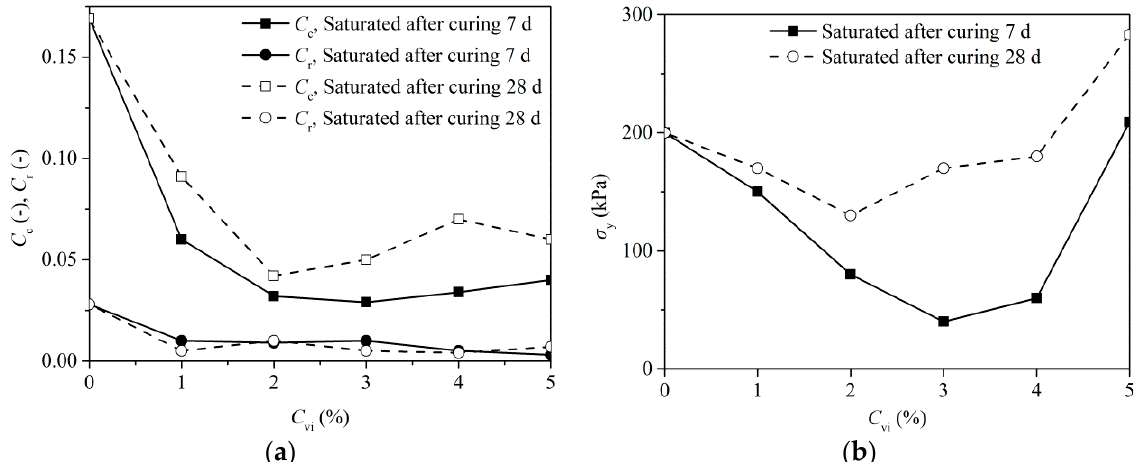
Figure 11. Compressibility and vertical yielding pressure of saturated untreated and cement-treated GRSs depending on cement content and curing time. ( a ) Compressibility; ( b ) Vertical yielding pressure.